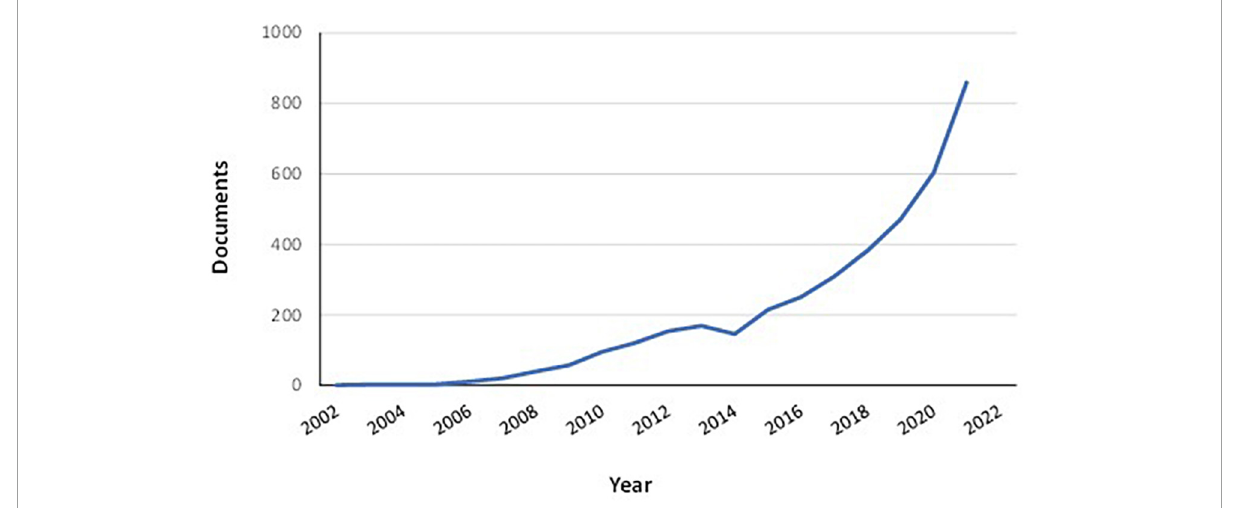
FIGURE1 Documents regarding vegetable biofortification published from 2002 to 2021. Documents by type: article (69.3%); review (18.7%); book chapter (8.1%); conference paper (2.2%); book (1.0%); other (0.7%). Data retrieved from Scopus R (cid:13) database (on 15 February 2022) using “biofortification” AND “vegetables” as key search